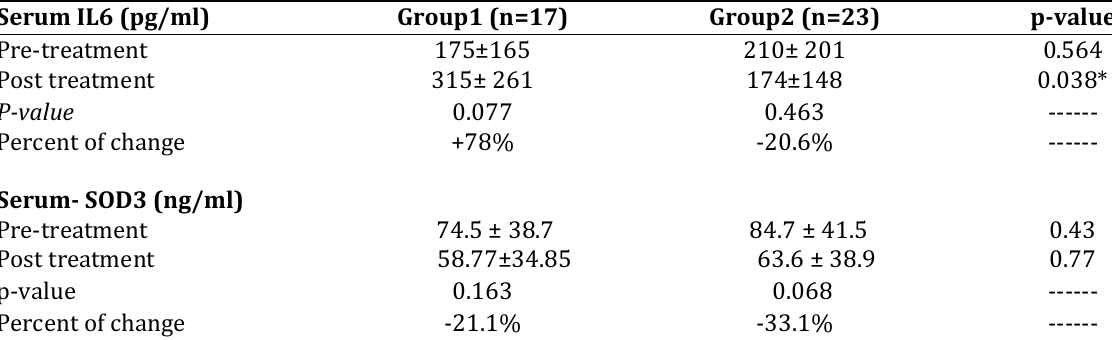
Table IV. Effect of conventional therapy alone and in combination with curcumin supplement on IL-6 and EC-SOD3 levels after 2